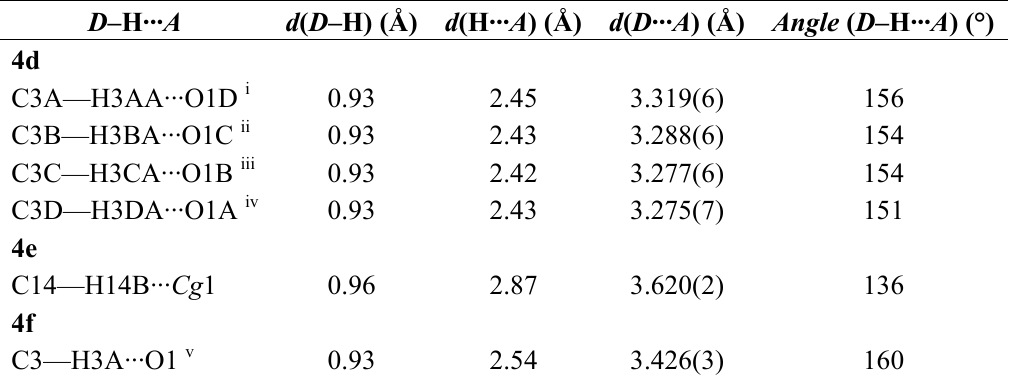
Table 2. Hydrogen bond geometries for compounds 4d , 4e and 4f .